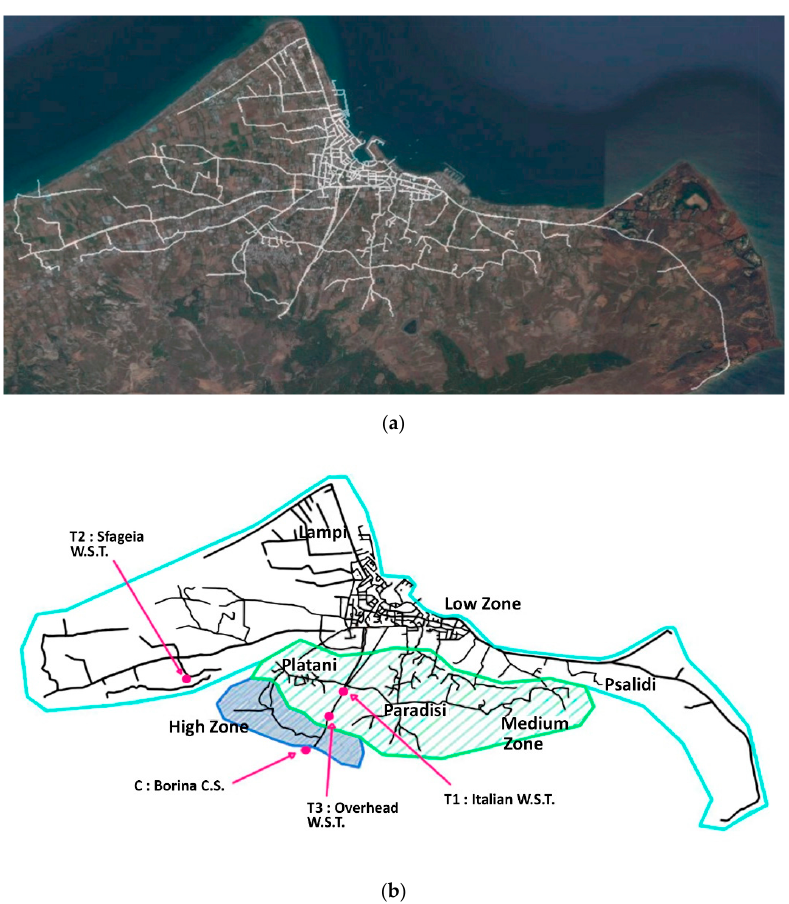
Figure 1. distribution network of Kos town in Goggle Earth ( a ); and in CAD format ( b ). Figure 1. Distribution network of Kos town in Goggle Earth ( a ); and in CAD format ( b